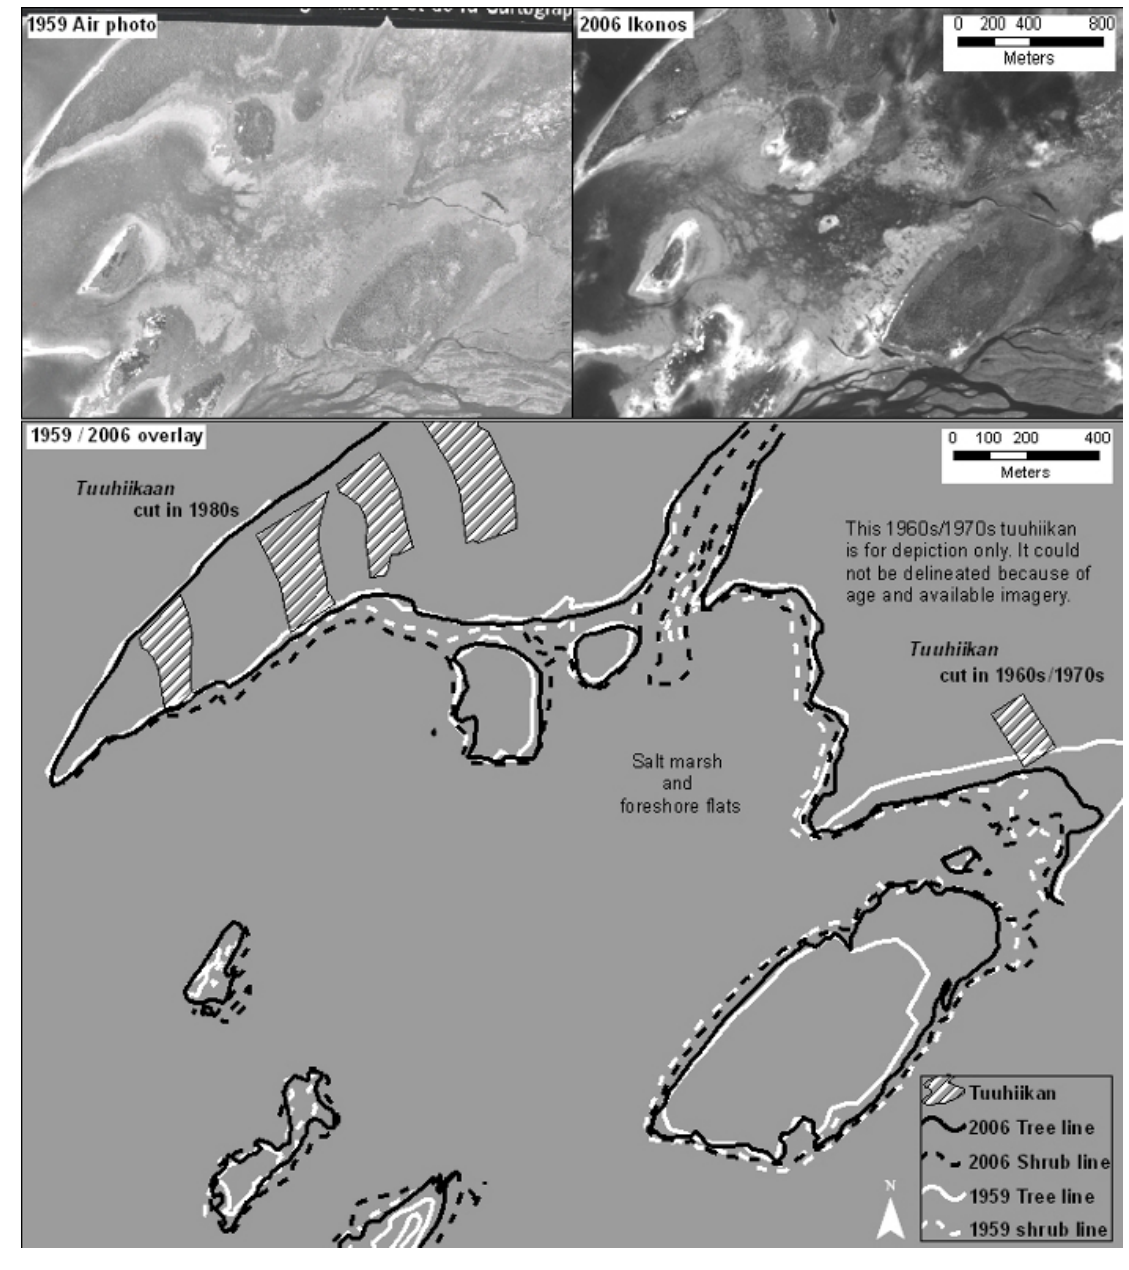
Fig. 6 . Temporal–spatial shifts in tuuhiikaan . The top two scenes compare a 1959 air photo and 2006 Ikonos image. Below is a vector overlay presented at double the scale of digitized tree and shrub lines used as proxies for shoreline movement because tidal variation between the two scenes cannot be controlled for (Grey 1983). The overlay shows the rapid rate of shoreline movement. The south-eastern tuuhiikan was cut in the 1960s or 1970s. Landscape change rendered the area poor for hunting, so four new tuuhiikaan were cut to the north-west, on the point, in the 1980s. The 1959 air photo was scanned at 6000 dpi and georeferenced to the Ikonos image using boulders, buildings, and other stable features as pass points, with a total RMS error of 8.09276m in Arc GIS 9.2. Digitizing was done at a 1:5,000